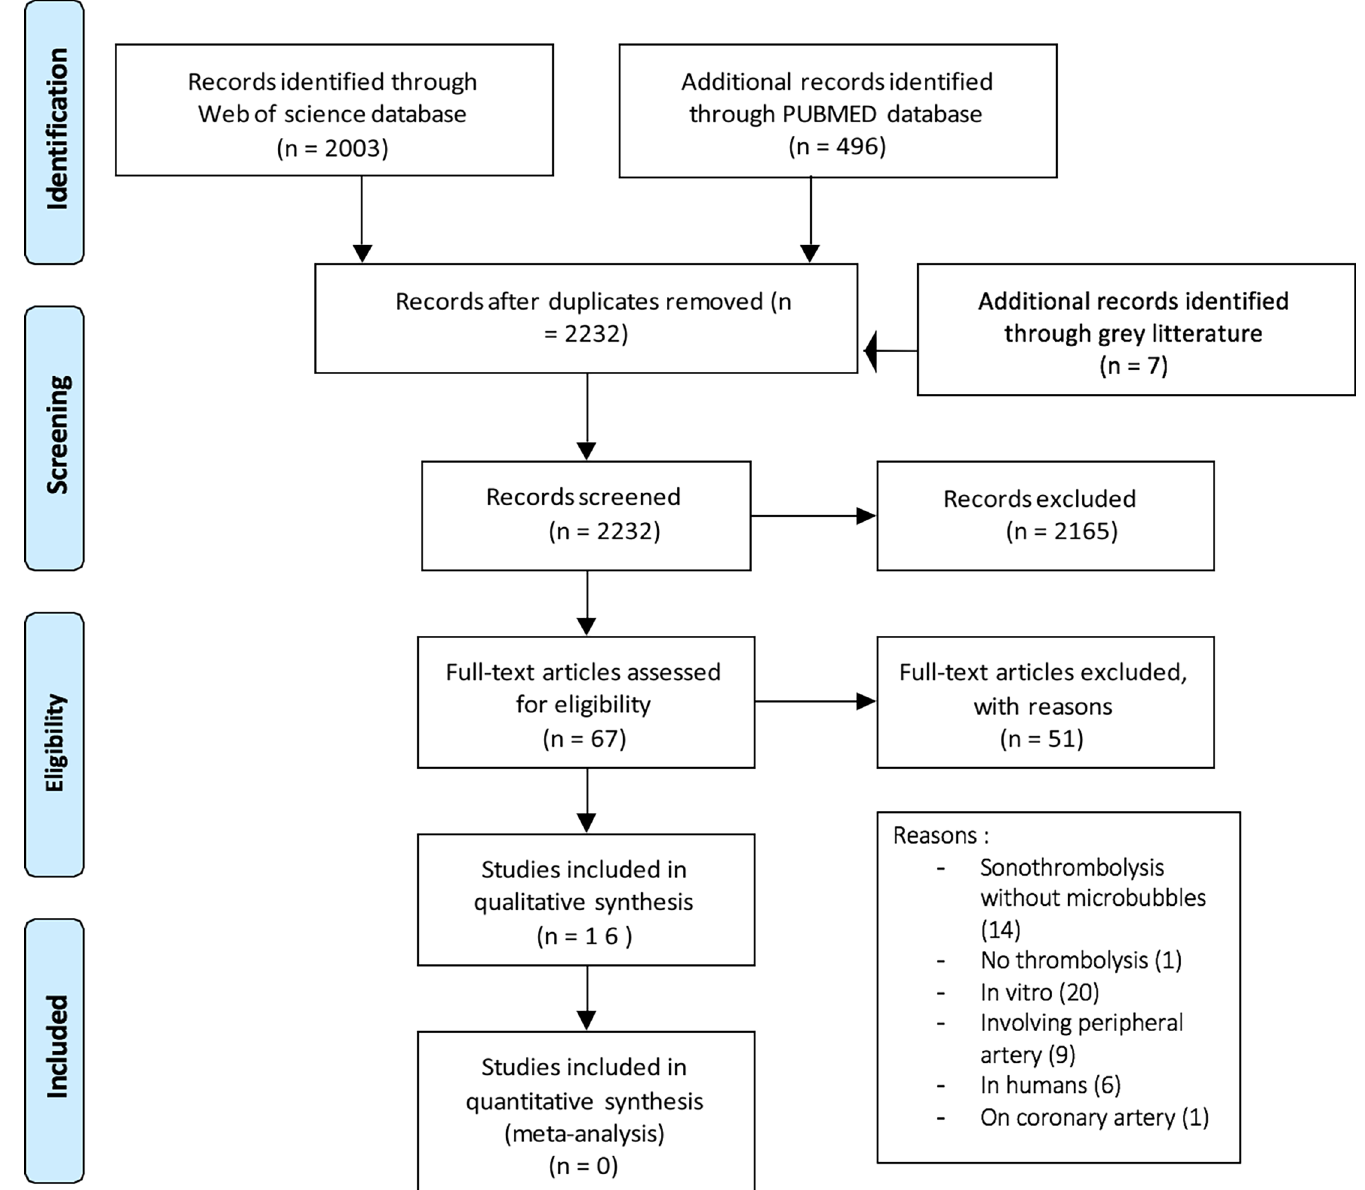
Fig 1. PRISMA 2009 flow diagram. Extracting schedule of the